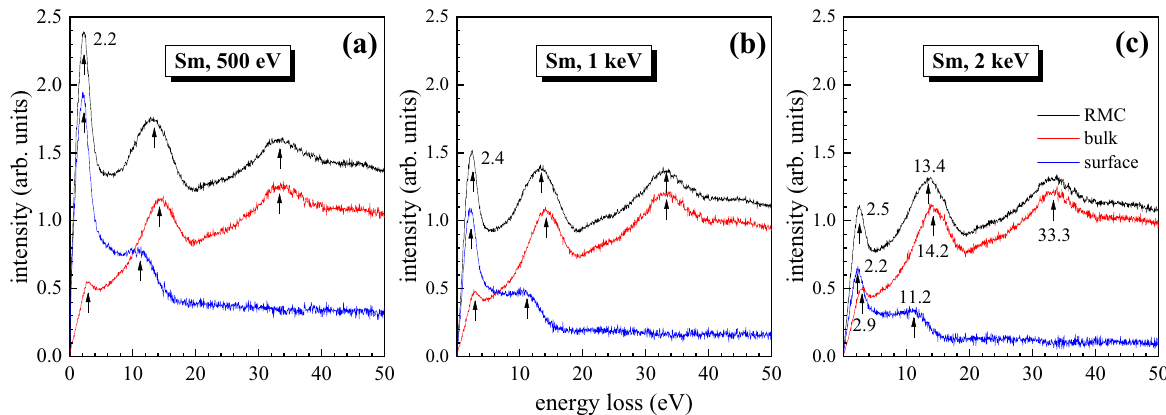
Figure 6. Comparison between the simulated REELS spectrum (black), pure bulk excitation component (red) and surface excitation component (blue), in which the peak broadening due to the elastic peak distribution has been